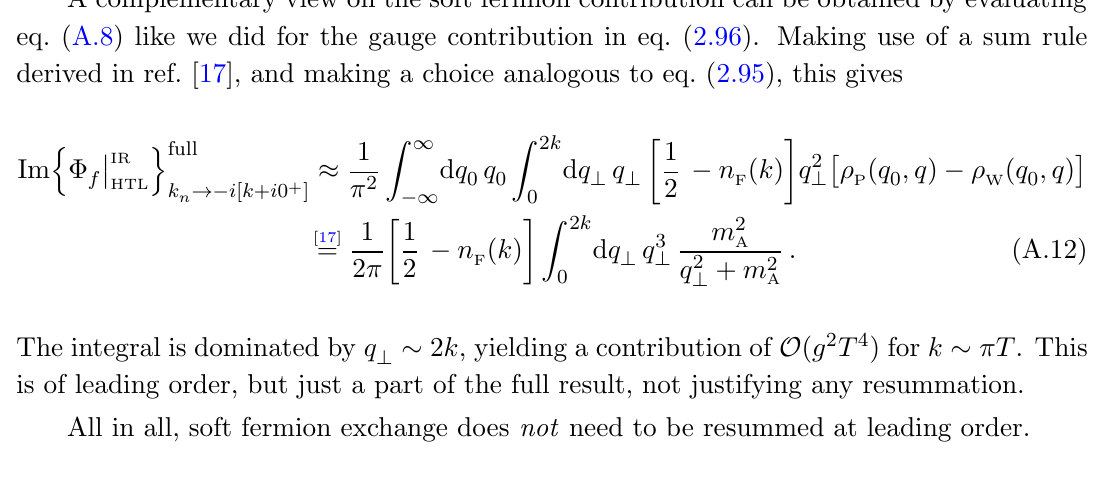
Figure 5 . An example of a 2 $ 3 scattering contributing to gravitational wave production. The notation is as in (cid:12)gure 2, and the magnitude of these scatterings is estimated in appendix